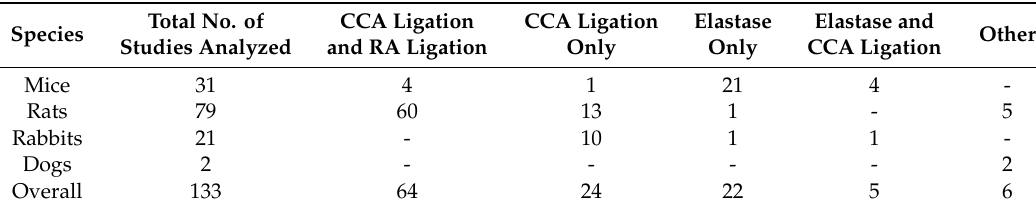
Table 2. Number of aneurysm type per species in the included studies. The vast majority (76%) of studies in rats used a combined CCA ligation and RA ligation model, whereas most mouse studies